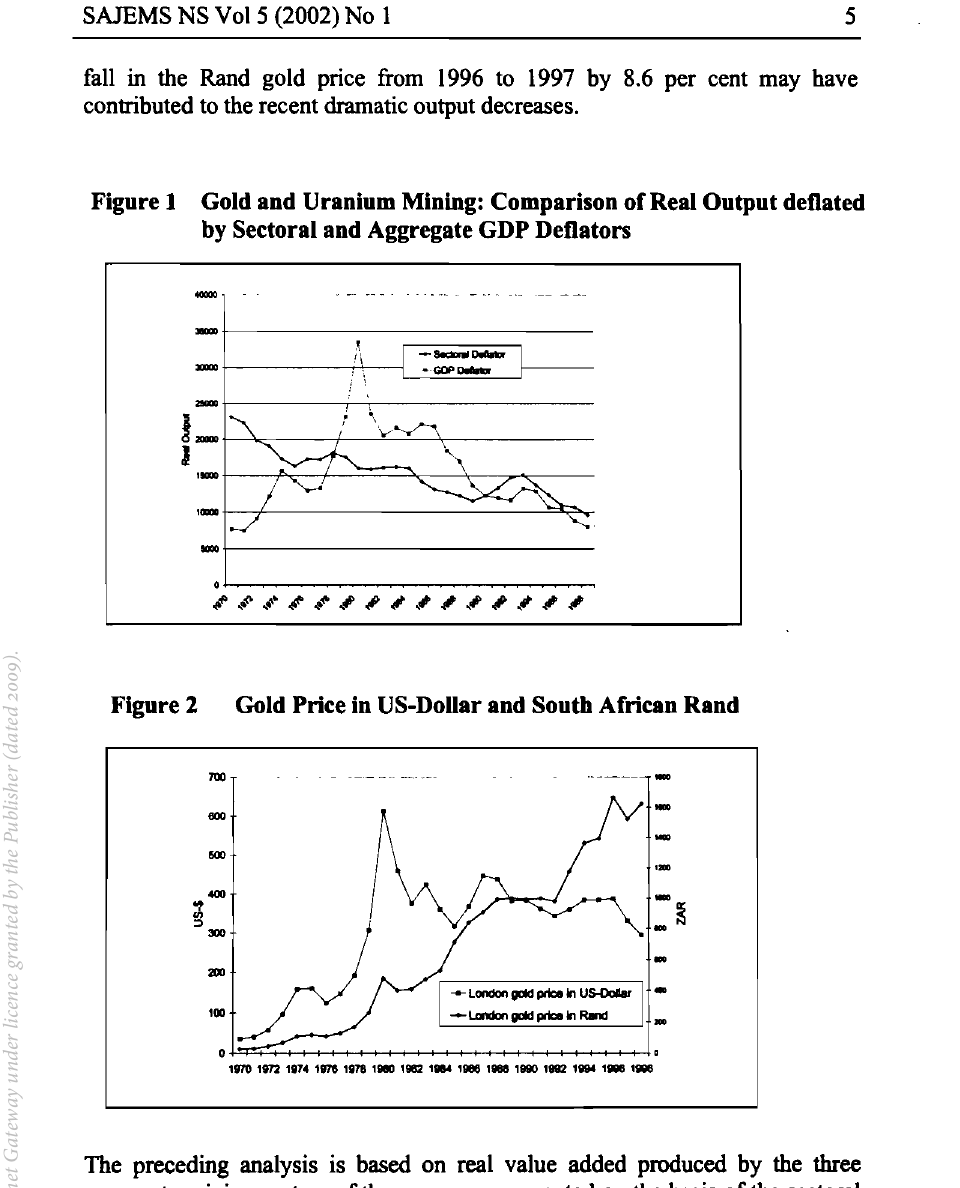
Figure 1 Gold and Uranium Mining: Comparison of Real Output deflated by Sectoral and Aggregate GDP Deflators